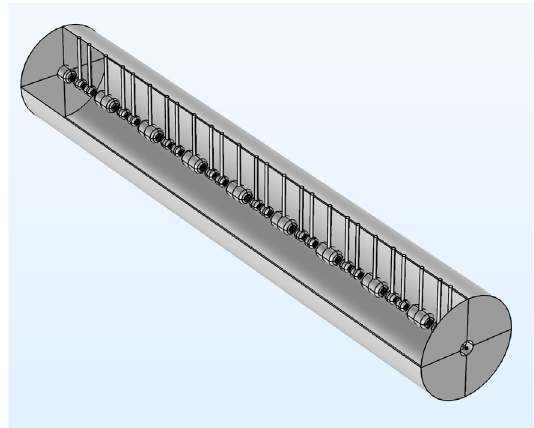
FIG. 15. The 3D model of the NIMMS QA-DTL tank design at 4 MV =